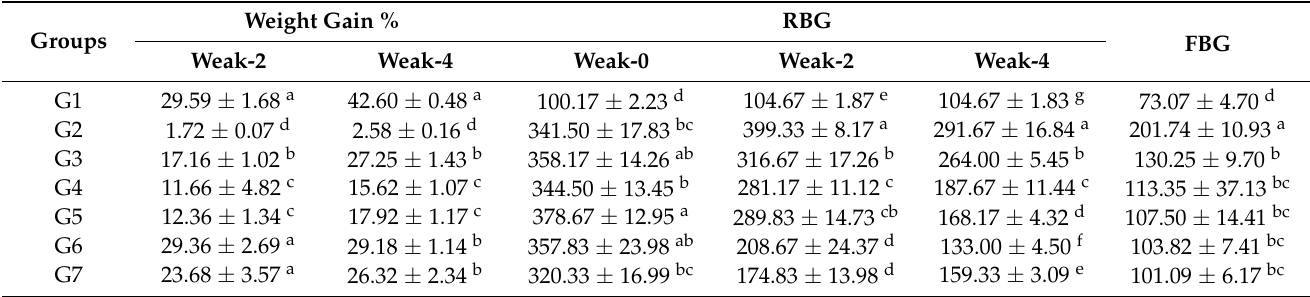
Table 3. Effect of probiotic-enriched fermented camel milk (FCM) combined with S. officinalis on weight gain, RBG, and FBG in STZ-induced diabetes in